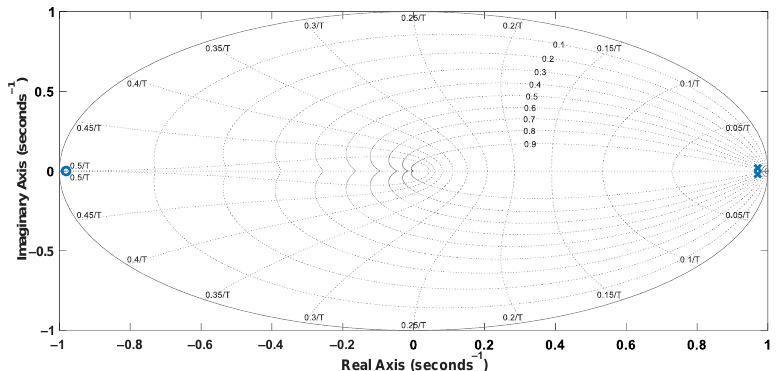
Figure 9. Pole-zero map of the discretized reference model.